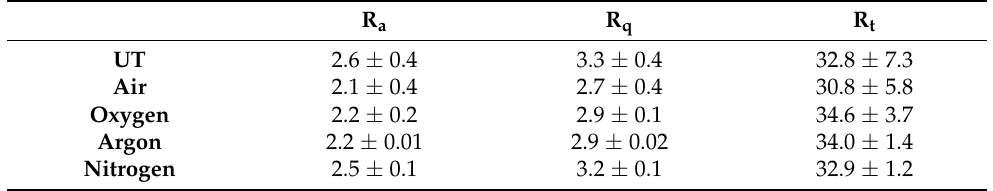
Figure 7. 3D images obtained by the optical profilometry. Table 4. POM surface roughness parameters of the unmodified and plasma-modified